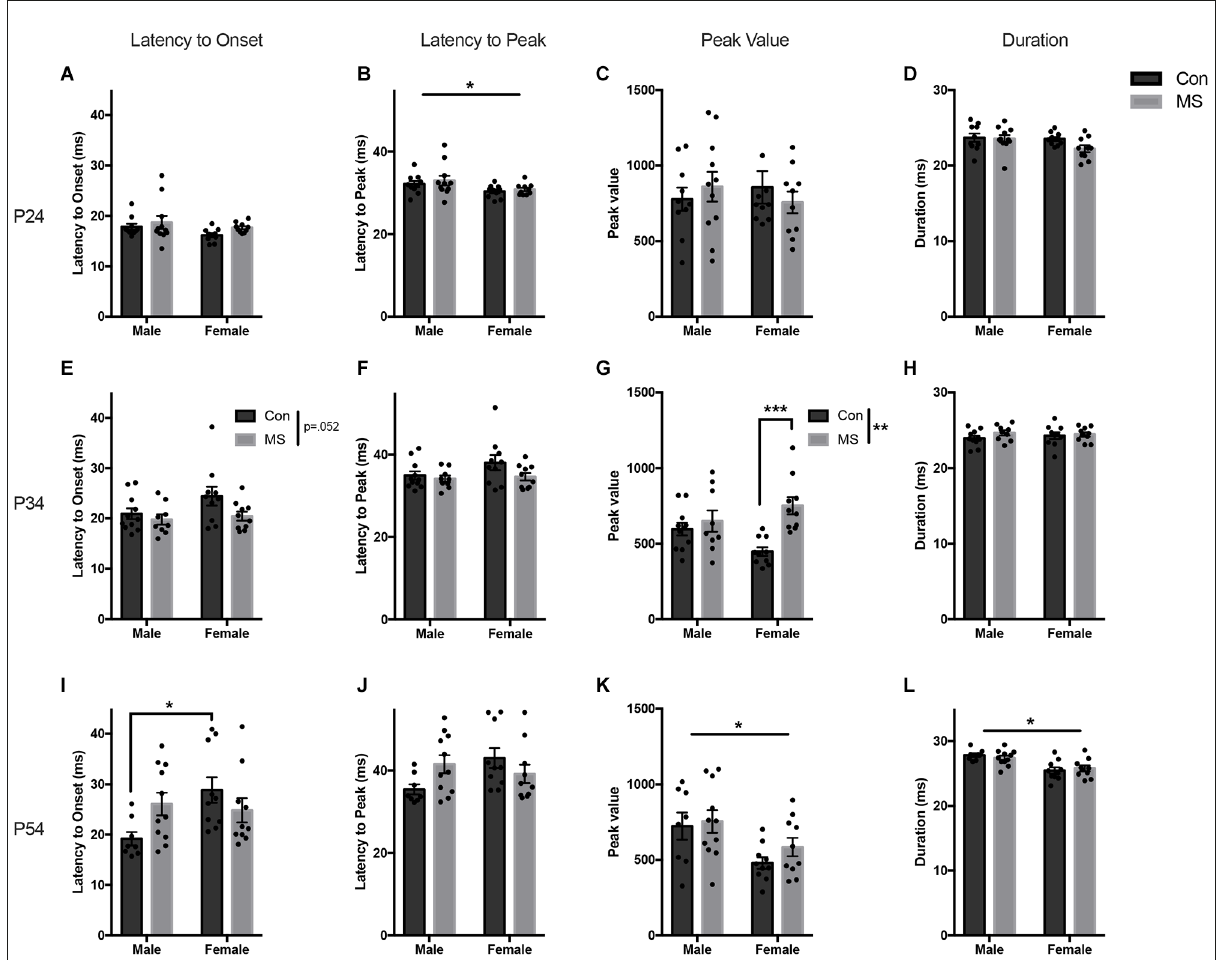
FIGURE2 Results from Experiment 1a, the effects of maternal separation (MS) on the baseline startle response. Graphs depict the latency to onset (ms), latency to peak (ms), peak value (arbitrary units), and duration (ms) on P24 (A–D) , P34 (E–H) , and P54 (I–L) . Control-reared groups are depicted by dark gray bars and MS-reared groups are depicted by light gray bars. Figures represent the mean group values ± SEM. Individual subjects are depicted by data points. * p < 0.05, ** p < 0.01, *** p <